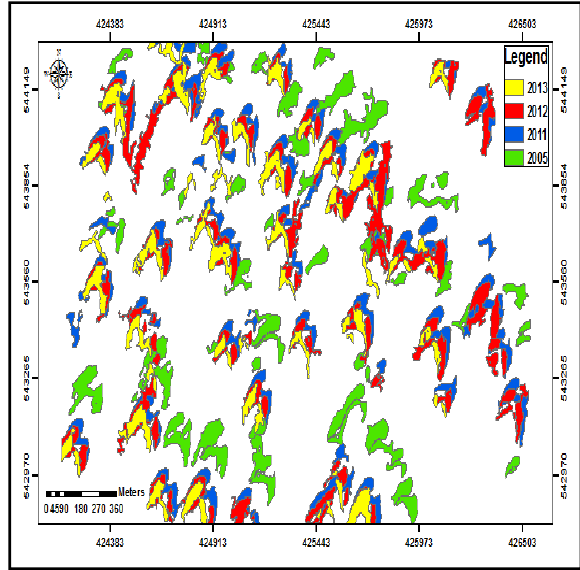
Figure 8: Overlapped barchans dunes layers